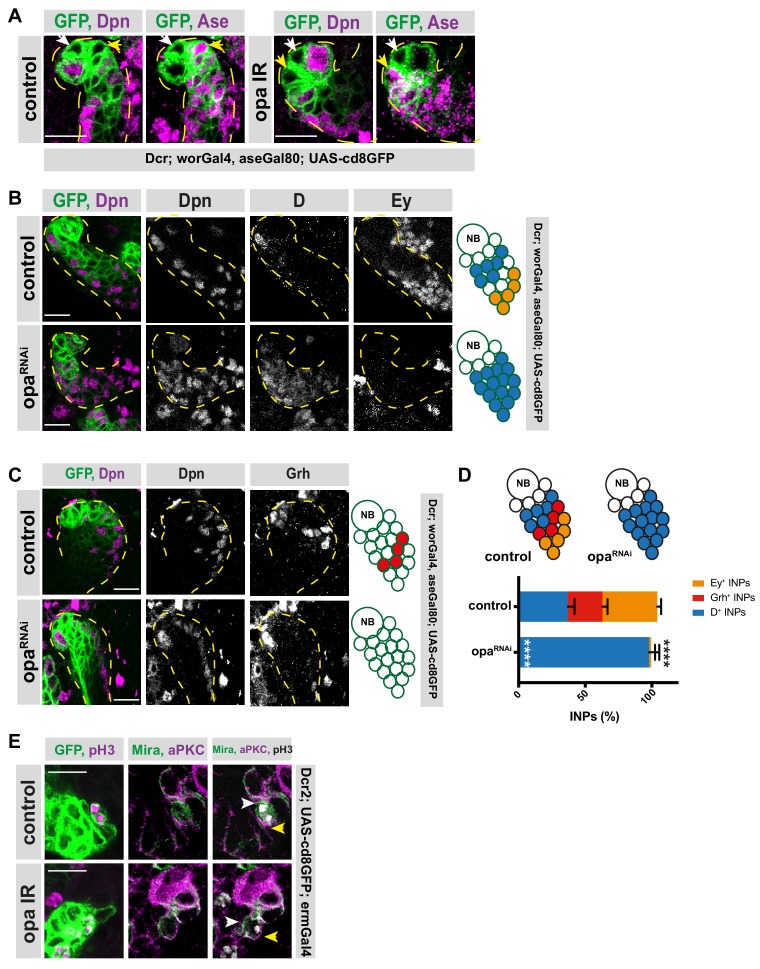
Opa regulates the transition from D-to-grh.(A) Close-up images of larval brains expressing RNAi against opa in type II lineages, stained for Dpn and Ase, lineages outlined with yellow dashed lines, Dpn-/Ase- INPs are marked with white arrowhead, Dpn-/Ase+ INPs are marked with yellow arrowhead, scale bar 10 μm (induced with worGal4, aseGal80, marked with membrane bound GFP). (B–C) Close-up images of larval brains expressing RNAi against opa in type II lineages, stained for Dpn, D and Ey (B), and Grh (C), lineages are outlined with yellow dashed line, scale bar 10 μm (induced with worGal4, aseGal80, marked with membrane bound GFP). (D) Quantification of Dpn+, D+, and Dpn+, Grh+, and Dpn+, Ey+ INPs in control and opa knock-down brains, n = 5, total INP numbers in control were normalized to 100%. Data represent mean ± SD, ***p<=0.001, Student’s t-test. (D+ INPs control 12.6 ± 1.5 [n = 5], opa RNAi 33.3 ± 2.35 [n = 6], p<0.001; Grh+ INPs control 8.8 ± 1.6 [n = 5], opa RNAi 0 [n = 6], p<0.001; Ey+ INPs control 14 ± 0.89 [n = 5], opa RNAi 0.5 ± 0.86 [n = 5], p<0.001). (E) Close-up images of larval brains expressing opa RNAi in INPs, stained for pH3, Mira and aPKC, the crescents of Mira staining are marked with white arrowhead, and the crescents of aPKC staining are marked with yellow arrowhead, scale bar 10 μm, (induced with ermGal4, marked with membrane bound GFP).10.7554/eLife.46566.018Figure 2—figure supplement 2—source data 2.Quantification of number of INPs in three different temporal identities between control versus opa-depleted brains with type II-specific driver (Figure 2—figure supplement 2D).